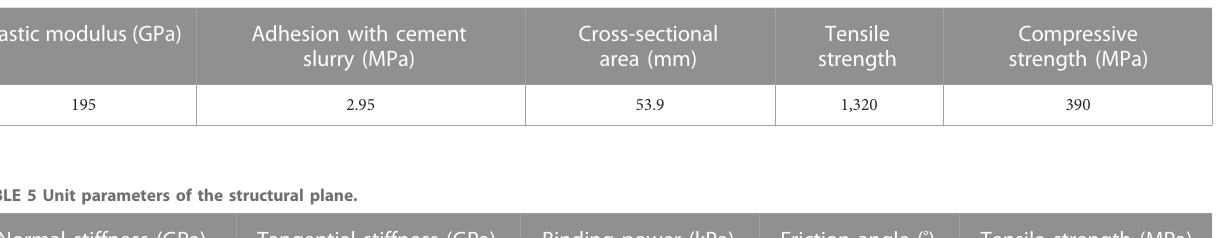
TABLE 4 Bolt parameters.